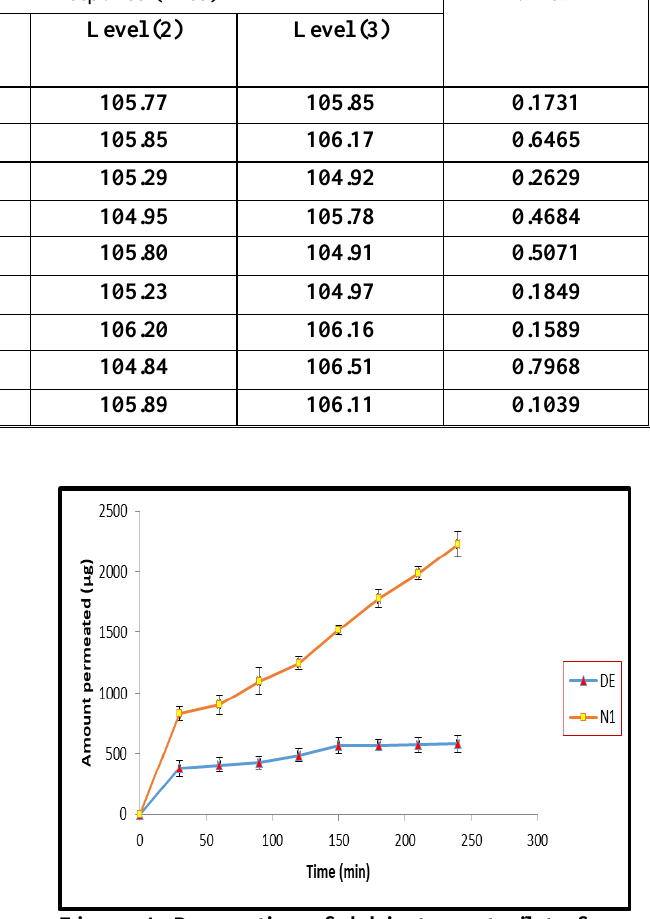
Table 5. Robustness data of DE analytical method validation variables